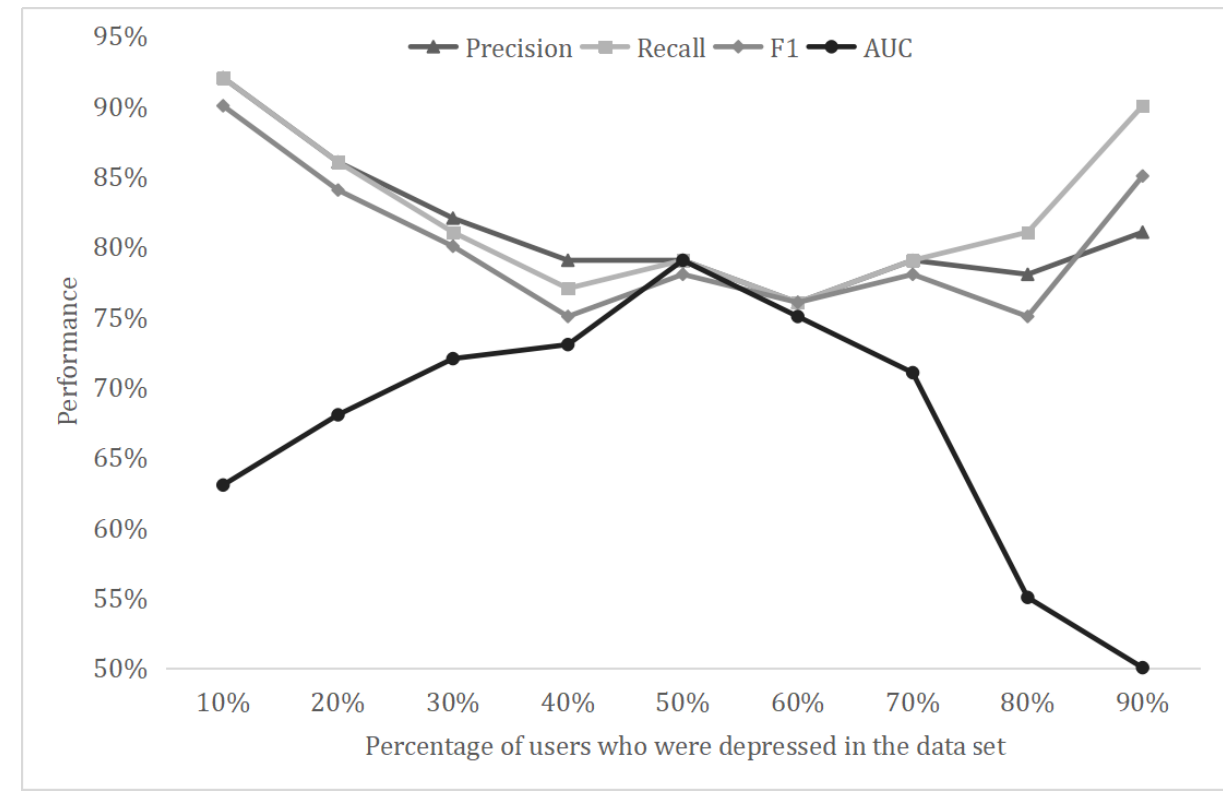
Figure 5. Scales of users who were depressed. AUC: area under the